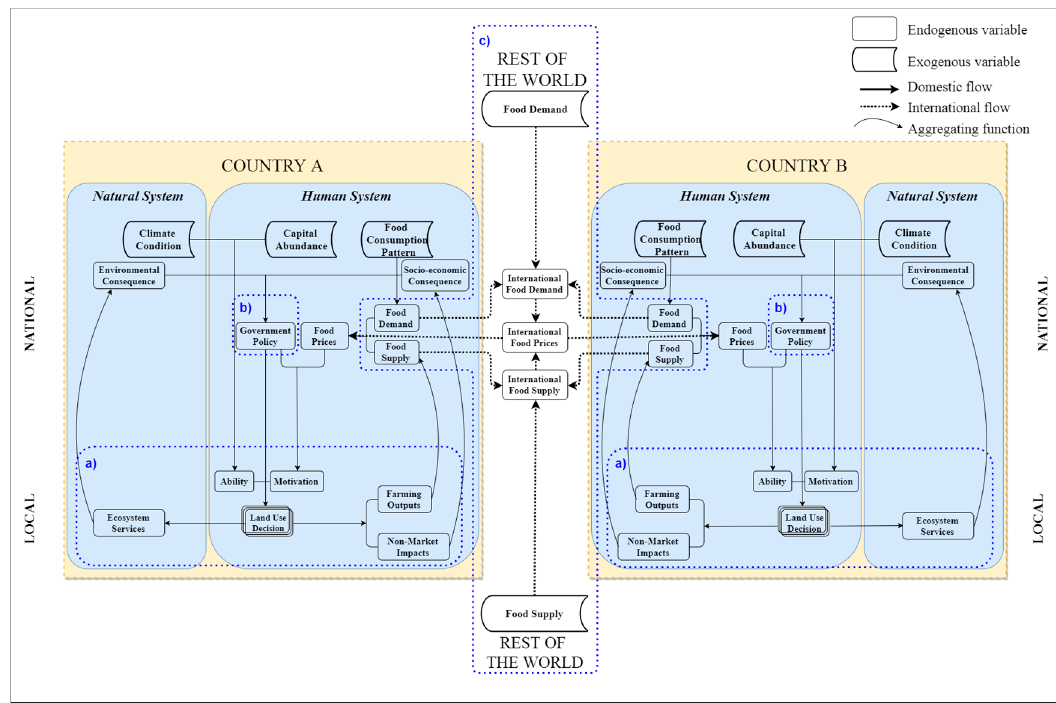
Figure 1. Conceptual model structure with ( a ) local land use, ( b ) government policy to be represented by agent-based models, and ( c ) global food trade to be represented by partial equilibrium (or system dynamics) models. Aggregating functions (curved arrows) are needed to translate outputs from local-level modules to national levels.